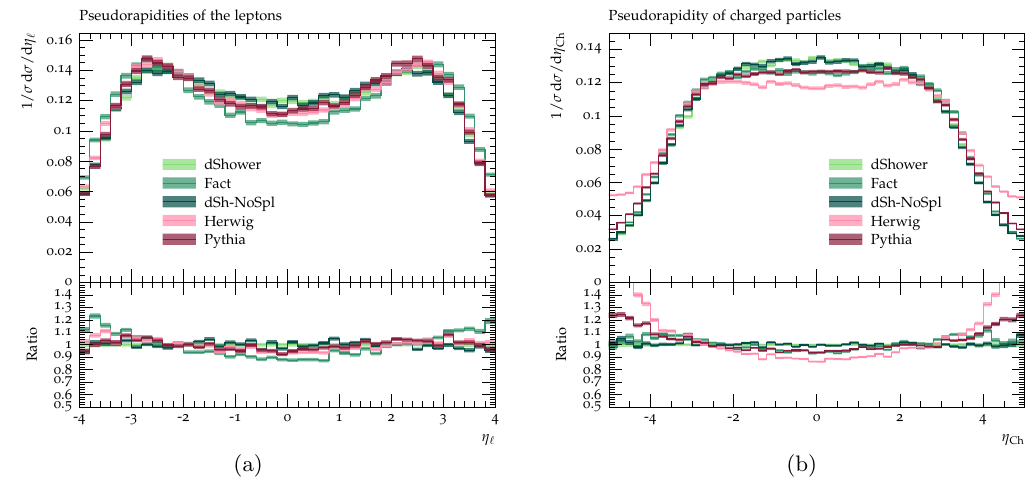
Figure 11 . (a) Pseudorapidities of the two charged leptons. (b) Pseudorapidities of all the charged particles produced in the event. The setup dShower is the reference in the ratio